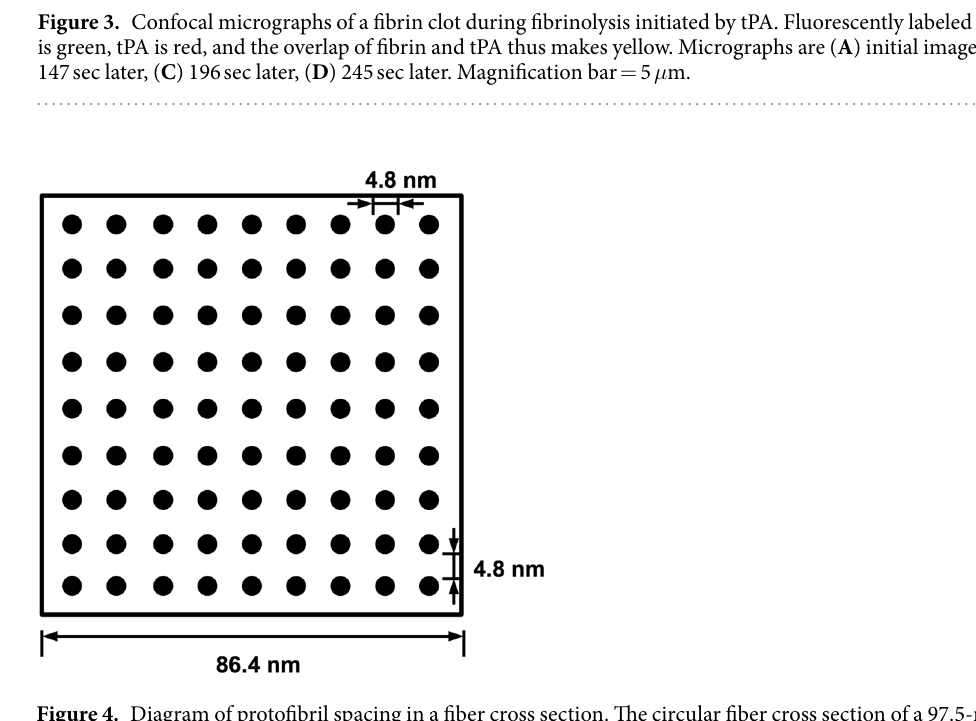
Figure 4. Diagram of protofibril spacing in a fiber cross section. The circular fiber cross section of a 97.5-nm diameter fiber is approximated by a square of equal area. Black circles are protofibril cross sections, each with diameter 4.8 nm. The distance from the edge of one protofibril to the edge of a neighboring protofibril is also 4.8